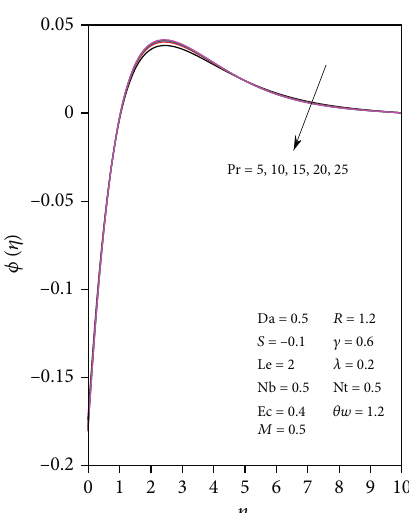
Figure 15: Concentration of nanoparticle pro fi le for di ff erent values of θ w .